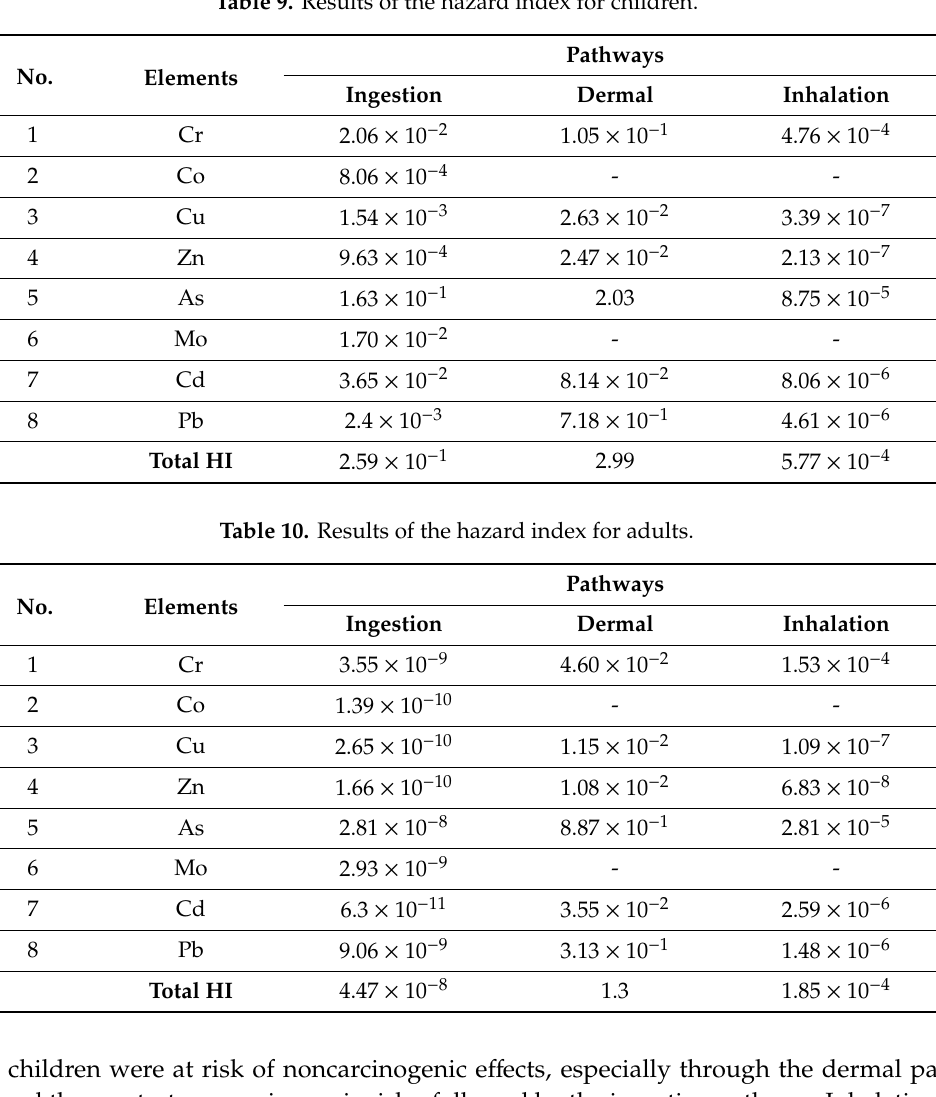
Table 9. Results of the hazard index for children.